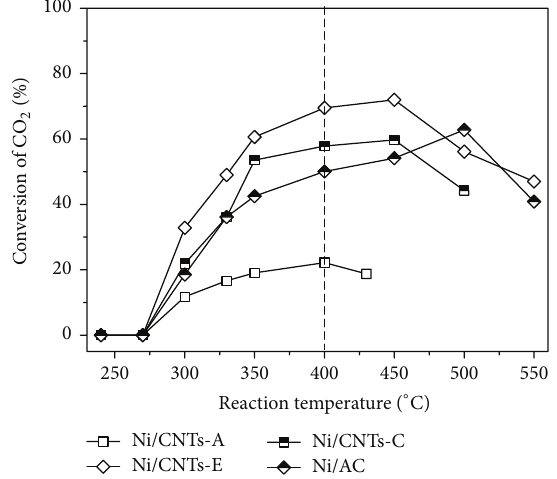
Figure 6: CO 2 conversion versus reaction temperature on the